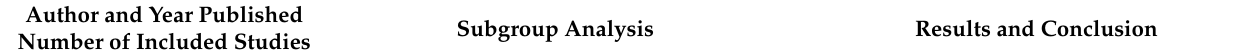
Table 4. Details of subgroup analysis and their results based on prognostic factors in the included